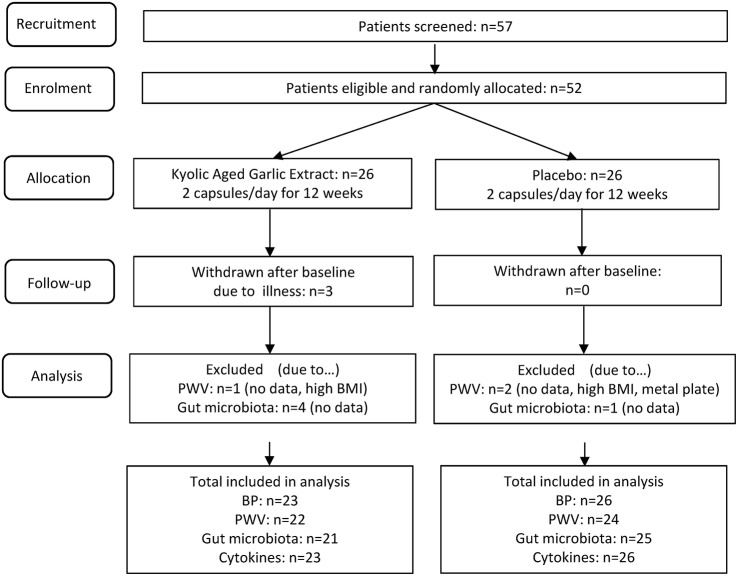
GarGIC trial flow chart.